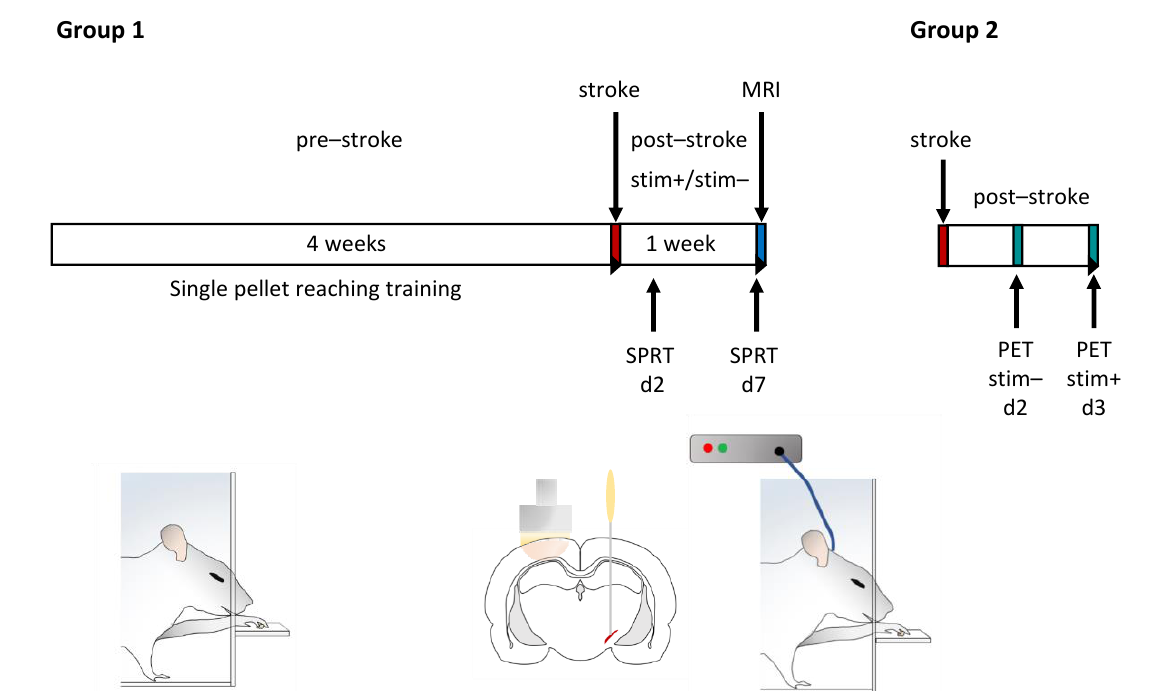
Figure 5. Schematic of the experimental design. Animals were divided into two groups: group 1 was trained in the single-pellet reaching (SPR) test daily (10 min) for 4 weeks. Then, a photothrombotic stroke was induced within the motor forelimb area of the dominant hemisphere and a stimulating electrode was implanted in the ipsilateral subthalamic nucleus (STN). After intervention, a continuous high frequency stimulation (HFS) ( n = 8) or sham stimulation ( n = 8) of the STN was started on day 1 after intervention and performed 24 h a day for 7 days. SPR was scored 1 day before as well as on day 2 and day 7 after intervention. Finally, infarct size was assessed using MR imaging on day 7 after intervention. Group 2 ( n = 6) also underwent photothrombosis and implantation of a stimulating electrode. On day 2 [ 18 F]FDG scans of 4 rats were available for analysis. SPRT, single-pellet reaching test; stim − , sham-stimulation stim+, STN-HFS.